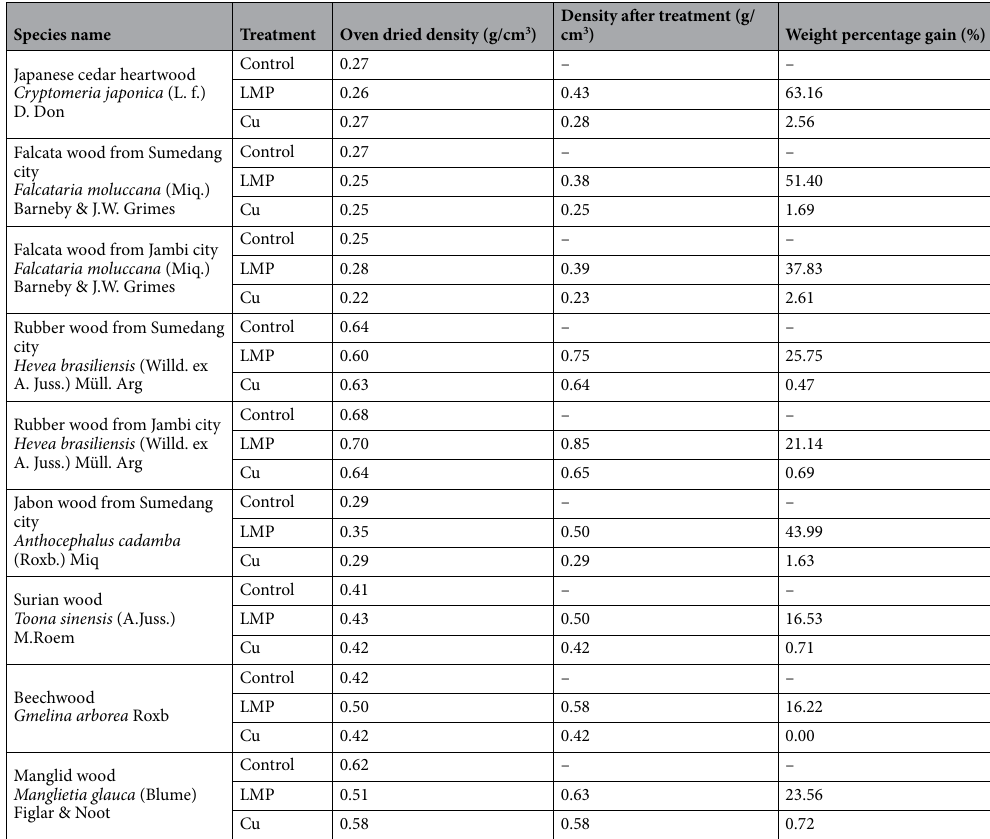
Table 2. The density and weight percentage gain of the low-molecule phenol and copper naphthenate (Cu) treated veneers and untreated veneer (control).